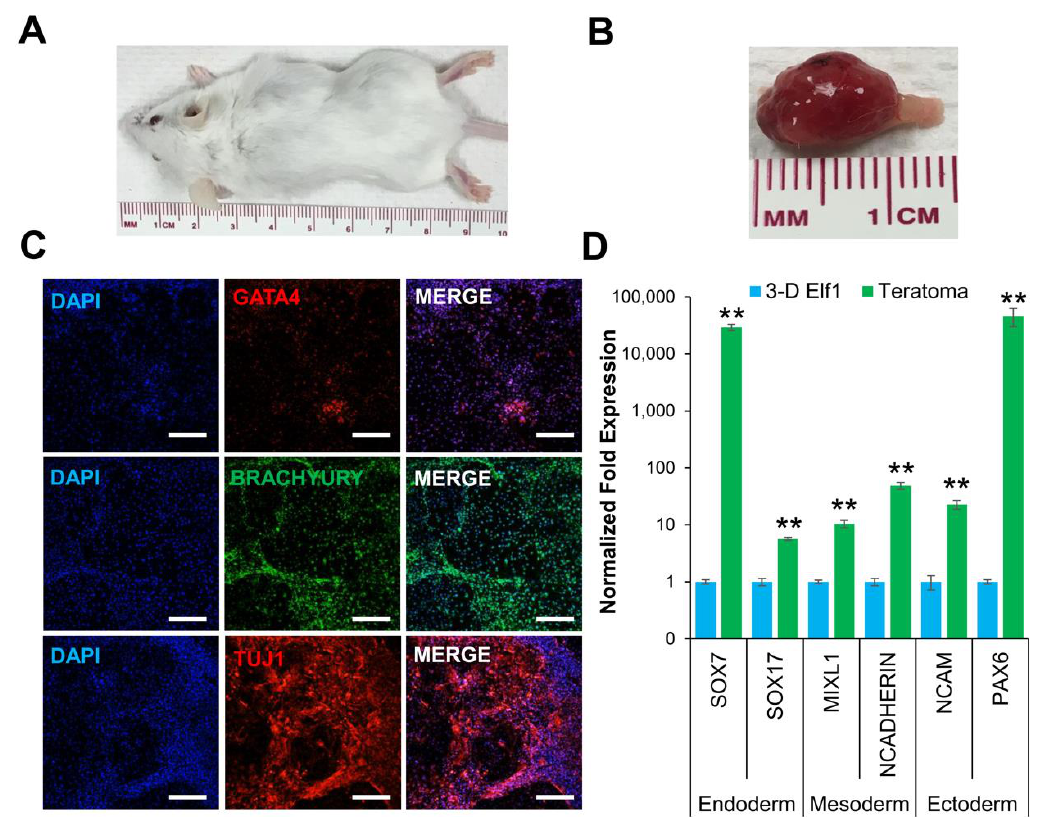
Figure 3. 3-D cultured naïve ESCs produced teratomas in SCID-beige mice. ( A ) Tumor growth was observed in all mice injected with 3-D grown Elf1 cells ( n = 3). ( B ) Explanted tumor at 4 weeks showed well-circumscribed lobular morphology consistent with teratoma formation. ( C ) Confocal images (10×) depict the presence of GATA4, BRACHYURY, and TUJ1 protein expression representing endoderm, mesoderm, and ectoderm, respectively. All scale bars represent 100 μm. ( D ) Gene expression analysis by qRT – PCR showed that teratomas expressed SOX7 , and SOX17 (endoderm) , MIXL1 , and N-CADHERIN (mesoderm), and NCAM, and PAX6 (ectoderm). Results are expressed as the fold expression ± SEM normalized to reference genes HMBS and GAPDH (** p ≤ 0.01).